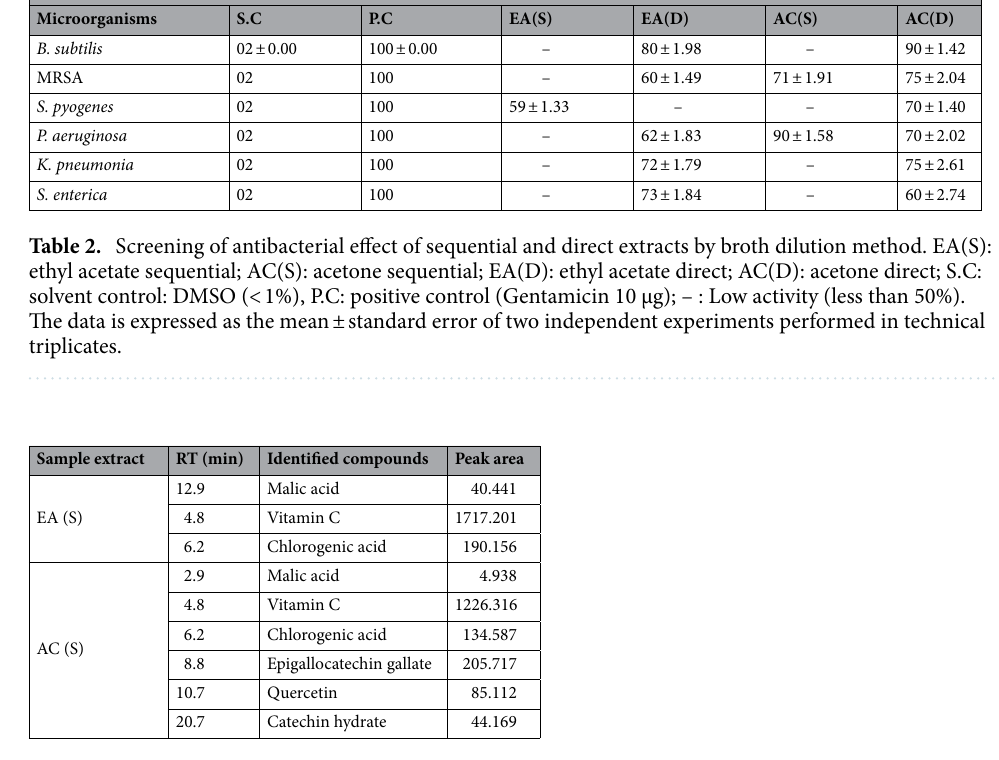
Table 3. Identified compounds in N. lappaceum ethyl acetate and acetone sequential fractions using HPLC– UV.